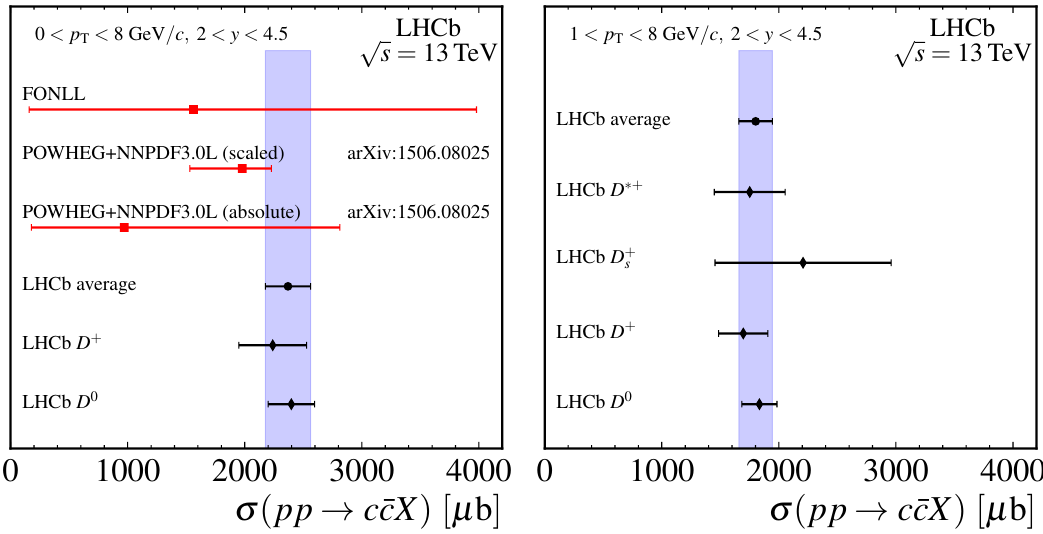
Figure 9. Integrated cross-sections (black diamonds), their average (black circle and blue band) and theory predictions (red squares) [1, 2] are shown (left) based on the D 0 and D + for 0 < p T < 8 GeV = c and (right) for measurements based on all four mesons for 1 < p T < 8 GeV = c. The \absolute" predictions are based on calculations of the 13 TeV cross-section, while the \scaled" predictions are based on calculations of the 13 to 7 TeV ratio multiplied with the LHCb measurement at 7 TeV [16].